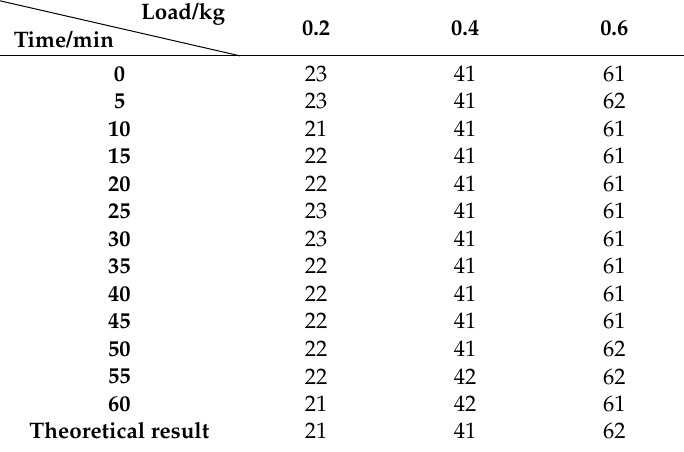
Table 3. Results of the experiment ( µε